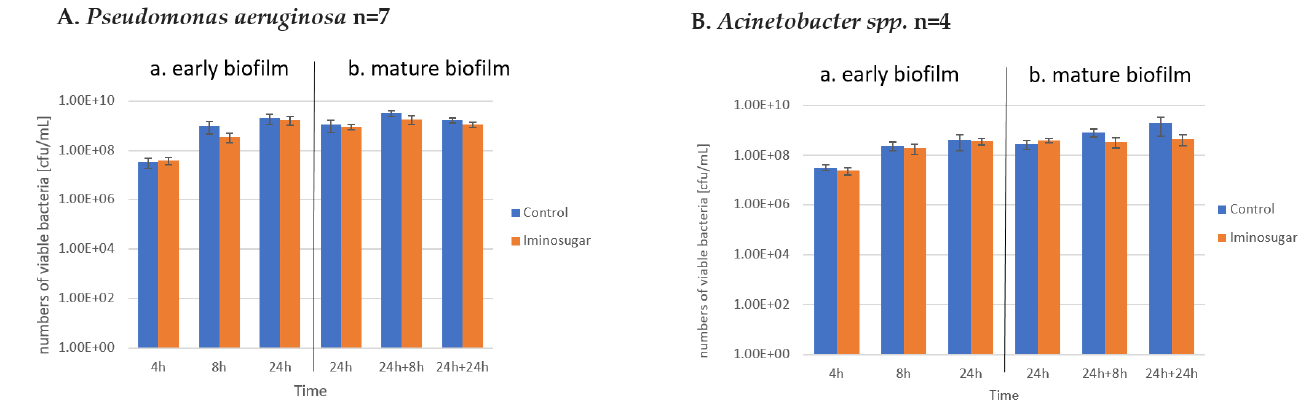
Figure 6. Effect of the tested iminosugar PDIA on numbers of viable population (n refers to the number of strains) of selected Gram-negative non-fermentive rods for ( A ) Pseudomonas aeruginosa and ( B ) Acinetobacter spp. in early ( a ) and mature ( b ) biofilm phase formation. Results depict logs of CFU/mL and measured at different time intervals. CFU, colony-forming units.